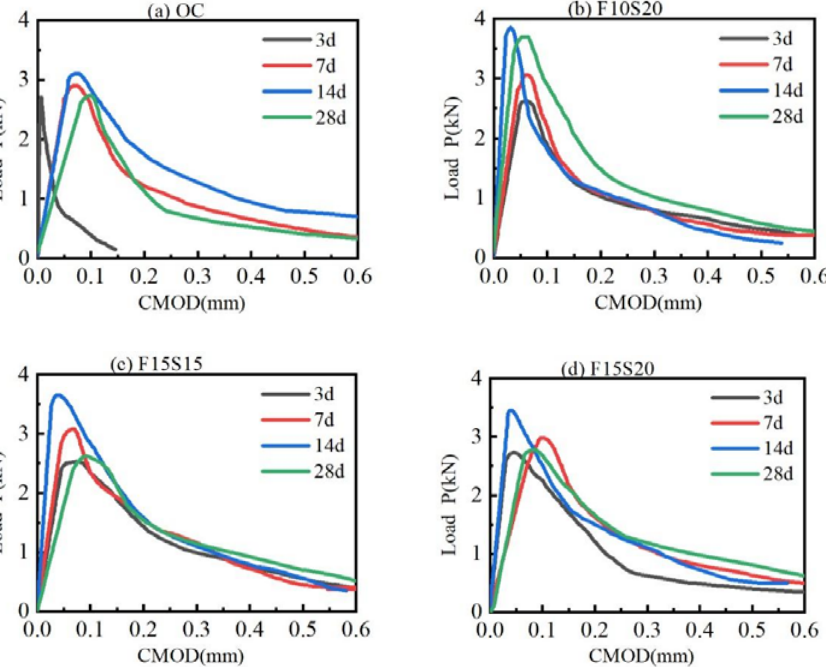
Figure 5. P-CMOD curves of the four types of concrete at different curing ages: ( a ) OC; ( b ) F10S20; ( c ) F15S15; ( d ) F15S20.